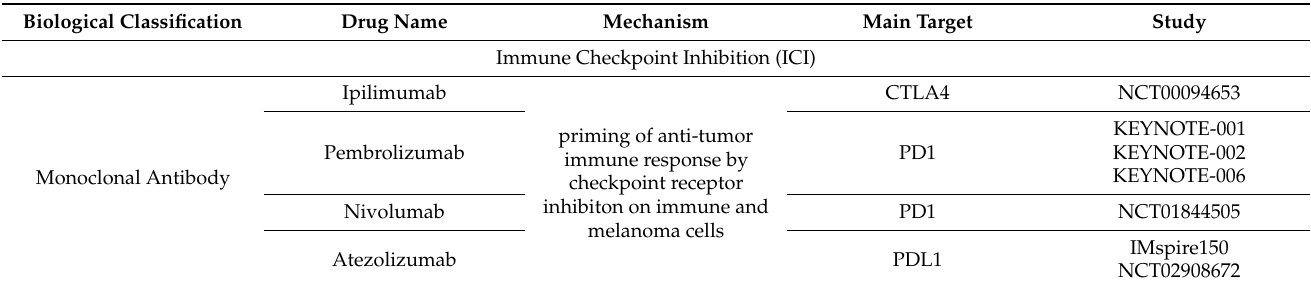
Table 1. Currently in-use ICIs and BRAF/MEK inhibitors for CM.